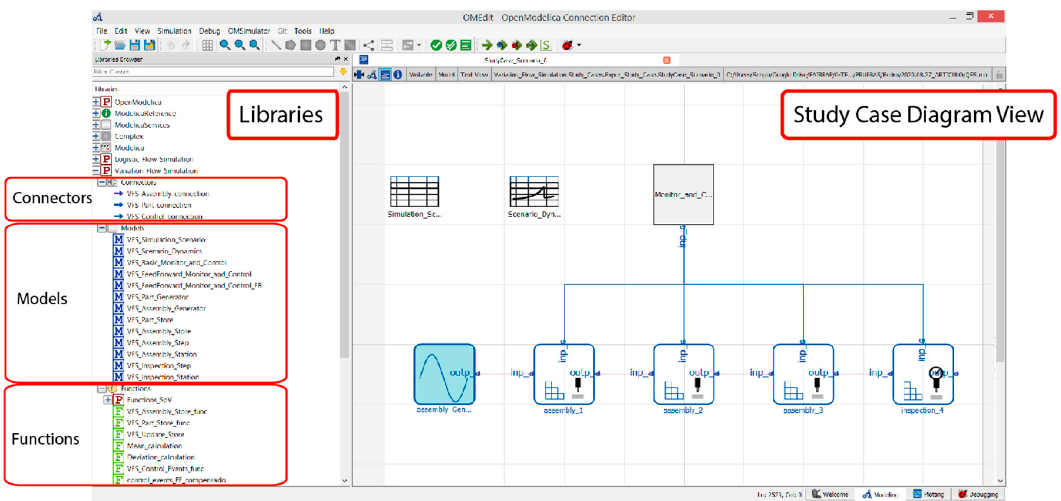
Figure 7. OpenModelica screenshot. On the left side: logistic flow simulation (LFS) and variation flow simulation (VFS) libraries, and some VFS internal classes (connectors, models, and functions). On the right side: a diagram view of an instantiated model for the study case.